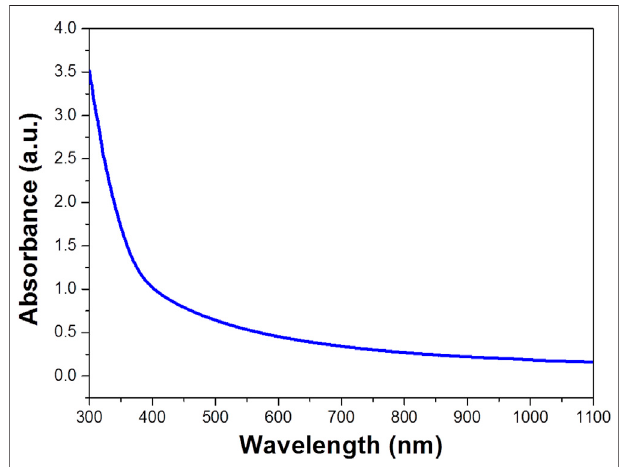
FIGURE 2 | UV-vis-NIR absorption spectra of WO 3 photocatalyst (concentration is 100 ppm).